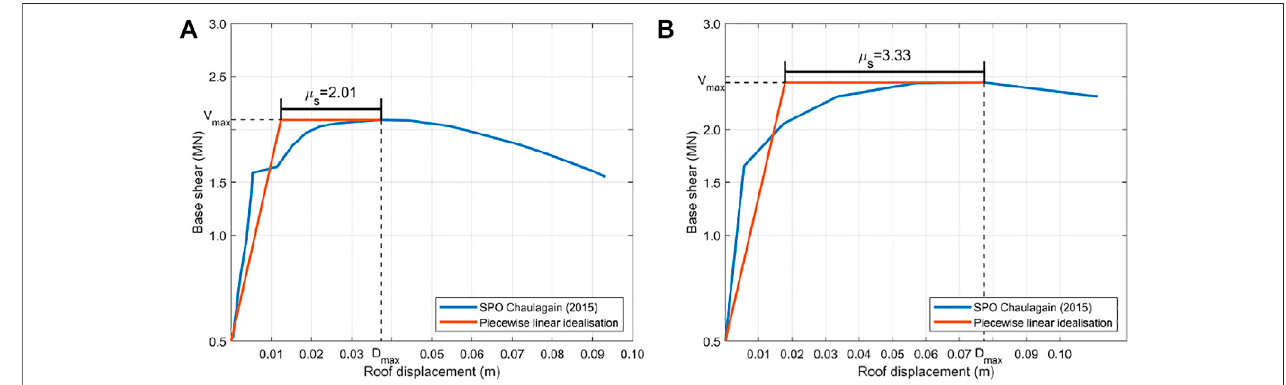
FIGURE 3 | The piecewise approximation of the SPO curves from Chaulagain (2016a) to allow calculation of μ s . (A) Non-engineered construction; (B) Engineered construction.